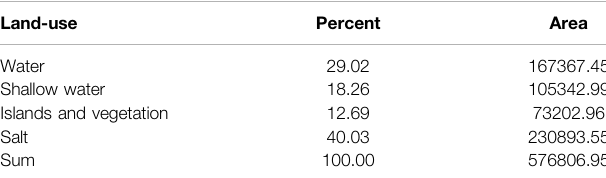
TABLE 5 | Land-use in the LU area in